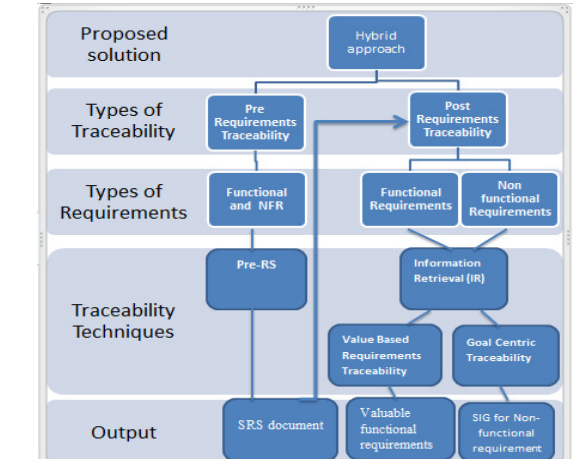
Fig. 1: Proposed Hybrid Approach for Effective Impact